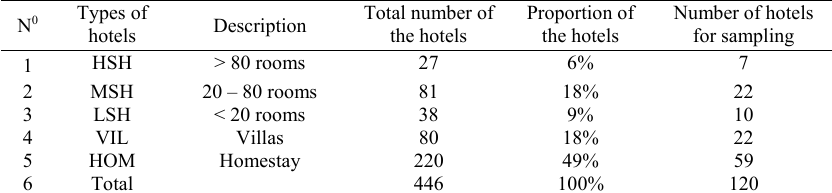
Fig. 1: The development of tourism sector and amount of waste recently (DOS, 2017; HAPWC, 2017) Table 1: The number of hotels in Hoi An city and the number of collected hotel for sampling N 0